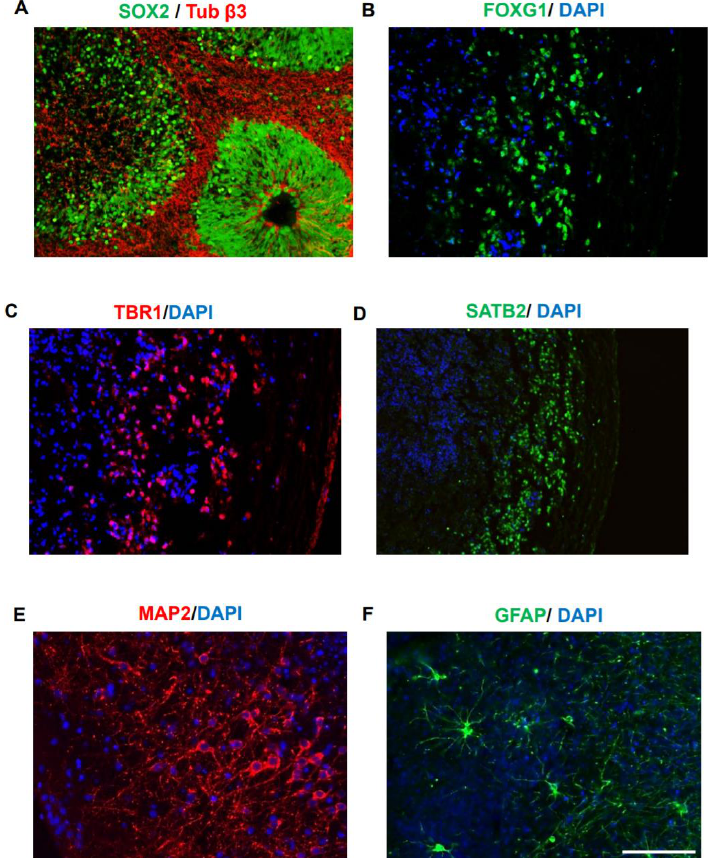
Figure 2. Generation of cortex-like cerebral organoids. COs were generated from a healthy iPSC line as previously described and characterized at 44 DIV and 220 DIV. ( A ). Characterization performed at 44 DIV indicated Sox2 positive ventricular zone (VZ) formation and β3 tubulin (Tuj1) positive neurons (in red) in the basal surface. Neuroepitelium-like structures similar to those seen in the brain during early stages of development were observed. ( B – F ). Characterization of COs at 220 DIV. FOXG1 immunostaining was used to confirm forebrain density ( B ). Appearance of cortical layer formation is analyzed using TBR1 (layer IV marker) ( C ) and SATB2 (layer II/IV specific marker) ( D ). The appearance of fully differentiated neurons and astrocytes was analyzed by immunostaining with MAP2 ( E ) and GFAP ( F ), respectively. The scale bar is 100 µm (showed in panel F) for all the images except D. For D, the scale bar is 200 µm.